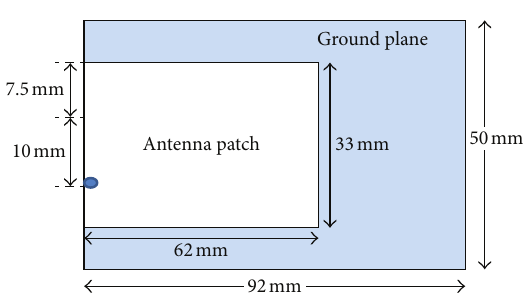
F 14: e structure of PIFA antenna at 0.9GHz [10]. of the antenna patch from the ground plane is the